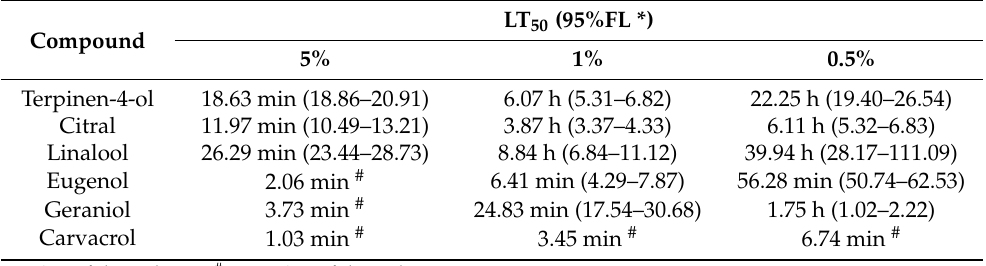
Table 1. Probit regression analysis of the toxicity (LT 50 ) of six terpenes against Sarcoptes mites in vitro. Compound